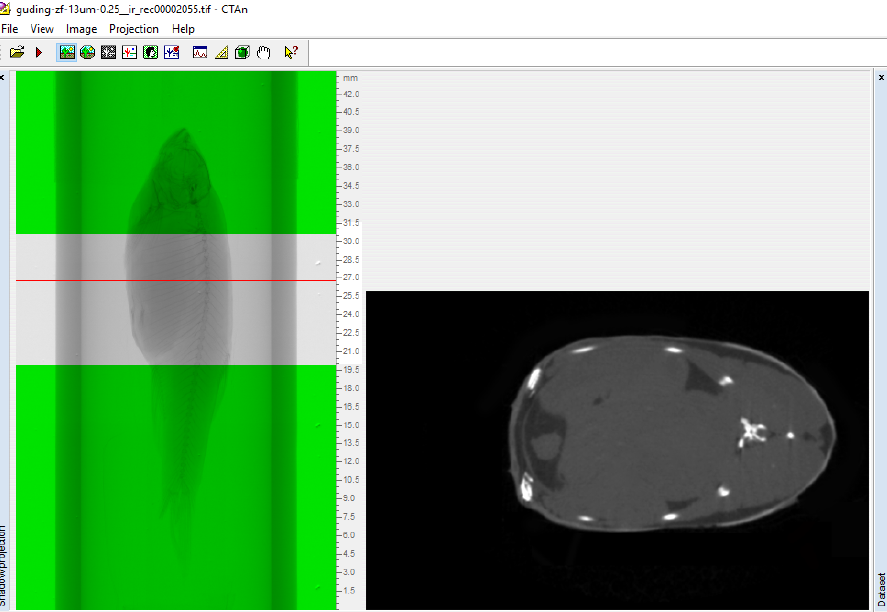
Figure 3. Selected and unselected areas in CTAn.